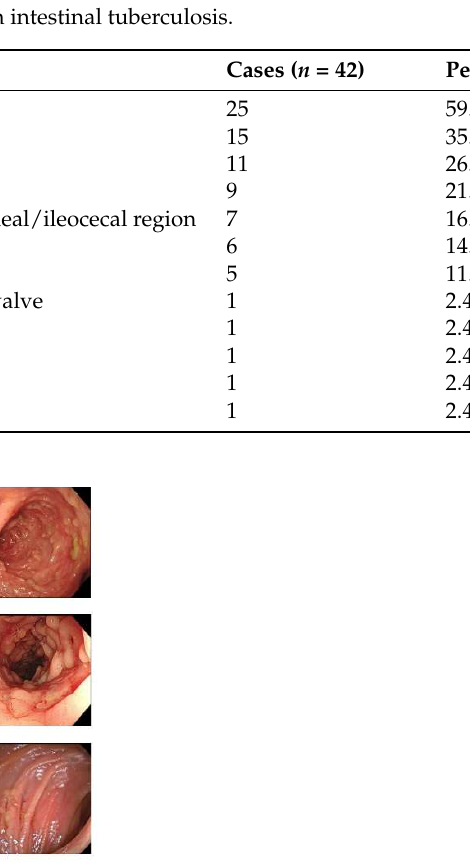
Table 5. Abdominal CT examination findings of patients with intestinal tuberculosis.